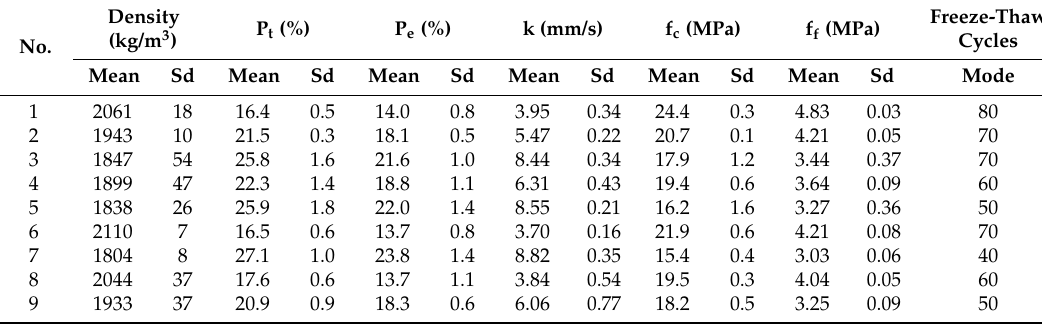
Table 4. Test results of pervious concrete (PC) properties.